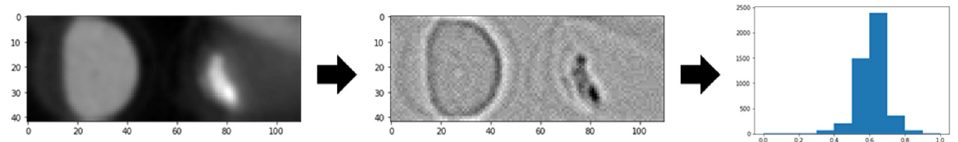
Figure 7. Normalization.